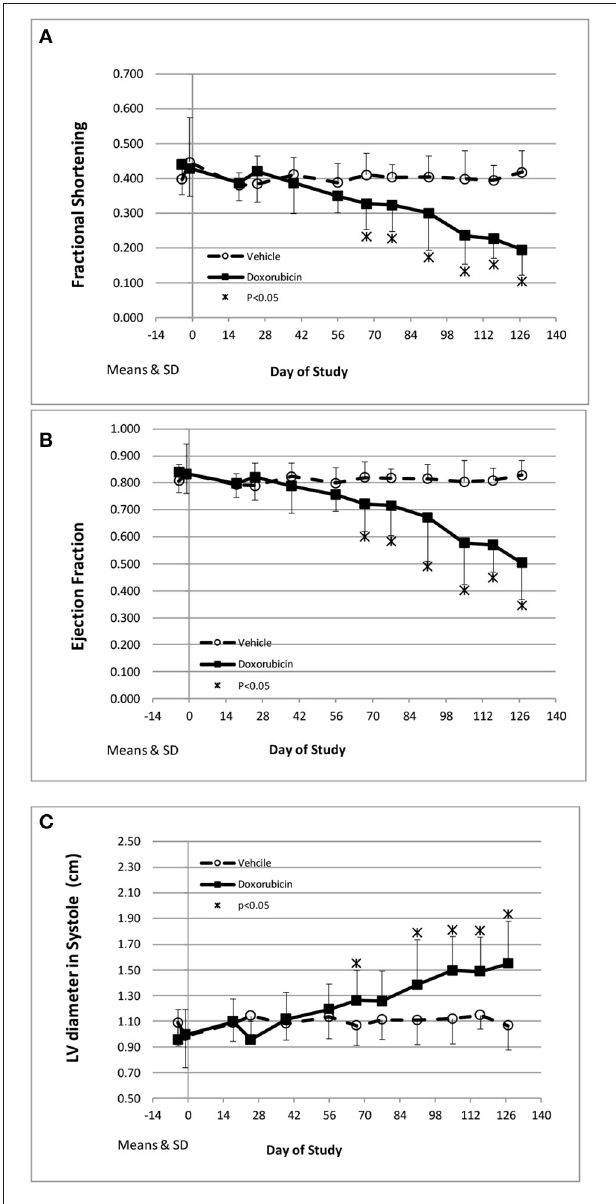
FIGURE 2 | Echocardiography endpoints. Changes in fractional shortening (A) , ejection fraction (B) , and left ventricular systolic diameter (C) over the course of the study. *Statistically different from vehicle